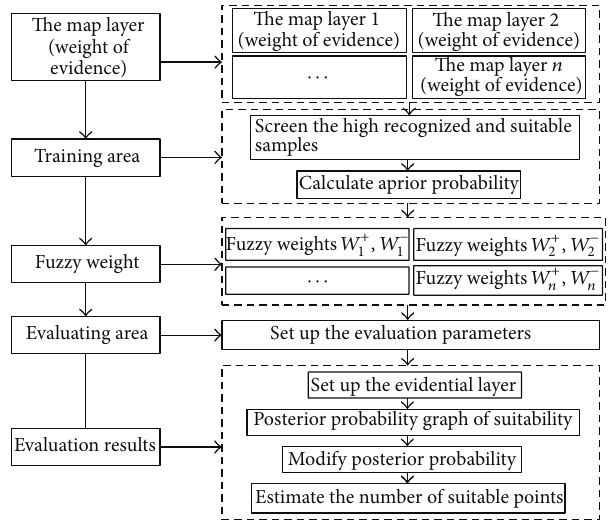
Figure 2: Flowchart of fuzzy weight of evidence.